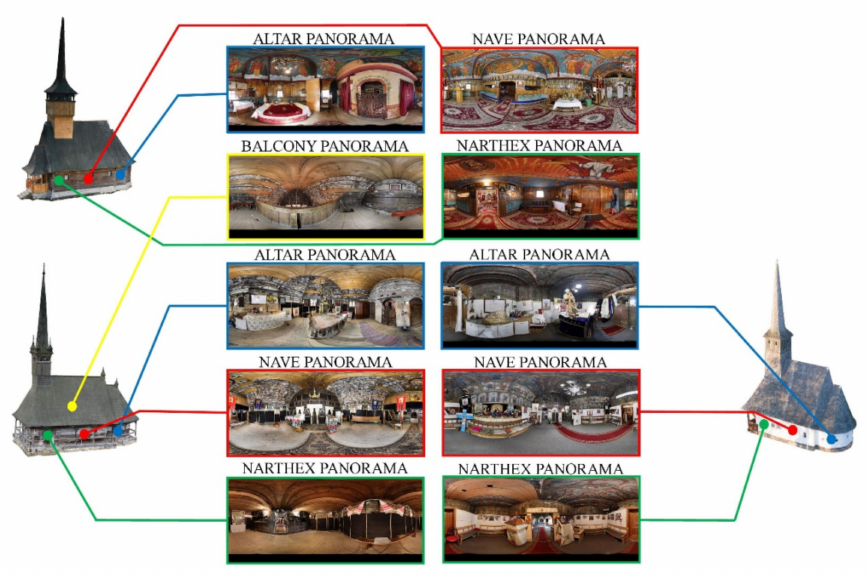
Figure 7. Illustrated presentation of the panoramas developed in terms of each wooden